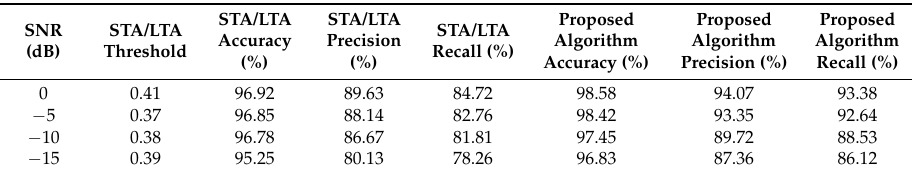
Table 1. The contrast of detection accuracy.